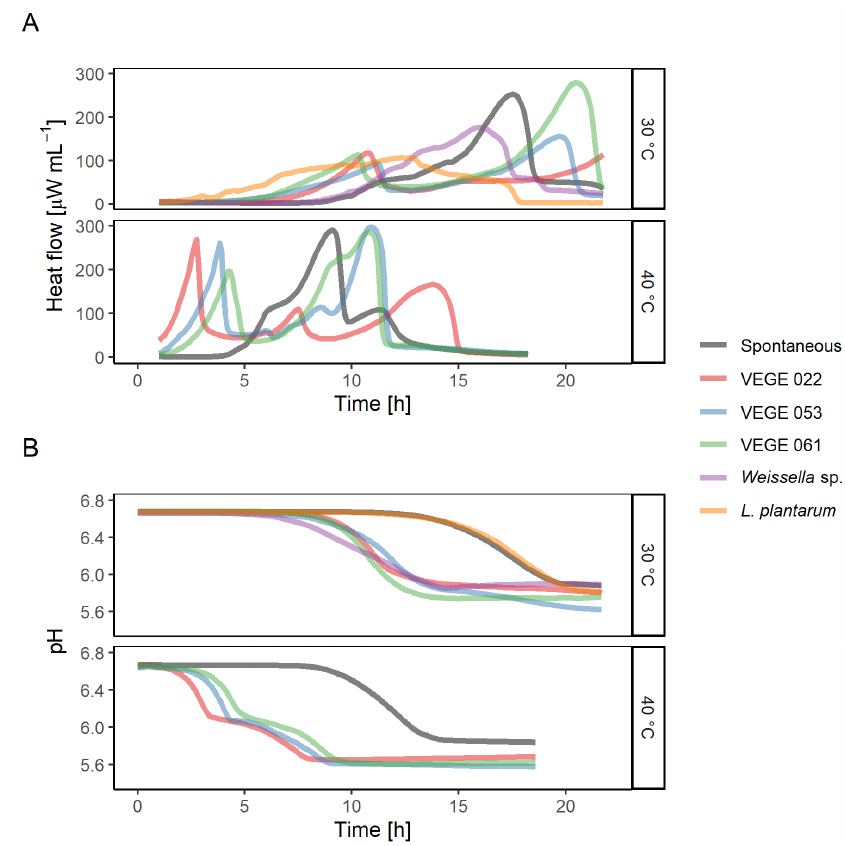
Figure 2. Small-scale fermentation by the starter cultures at 30 and 40 °C. The spontaneous sample was not inoculated. ( A ) Typical microcalorimetry heat flow curves. ( B ) pH change.